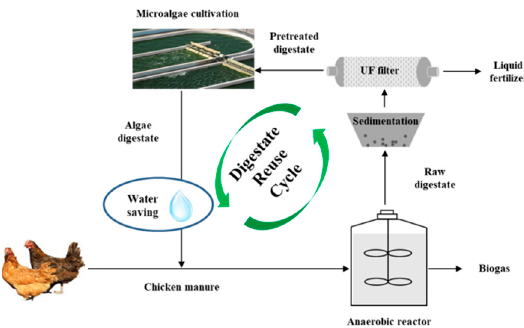
Figure 4. A closed loop system of CM diluted by algae digestate water.